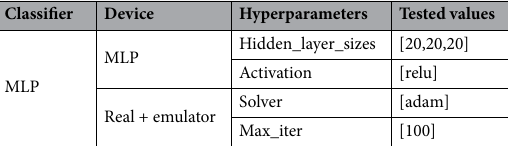
Table 5. MLP model